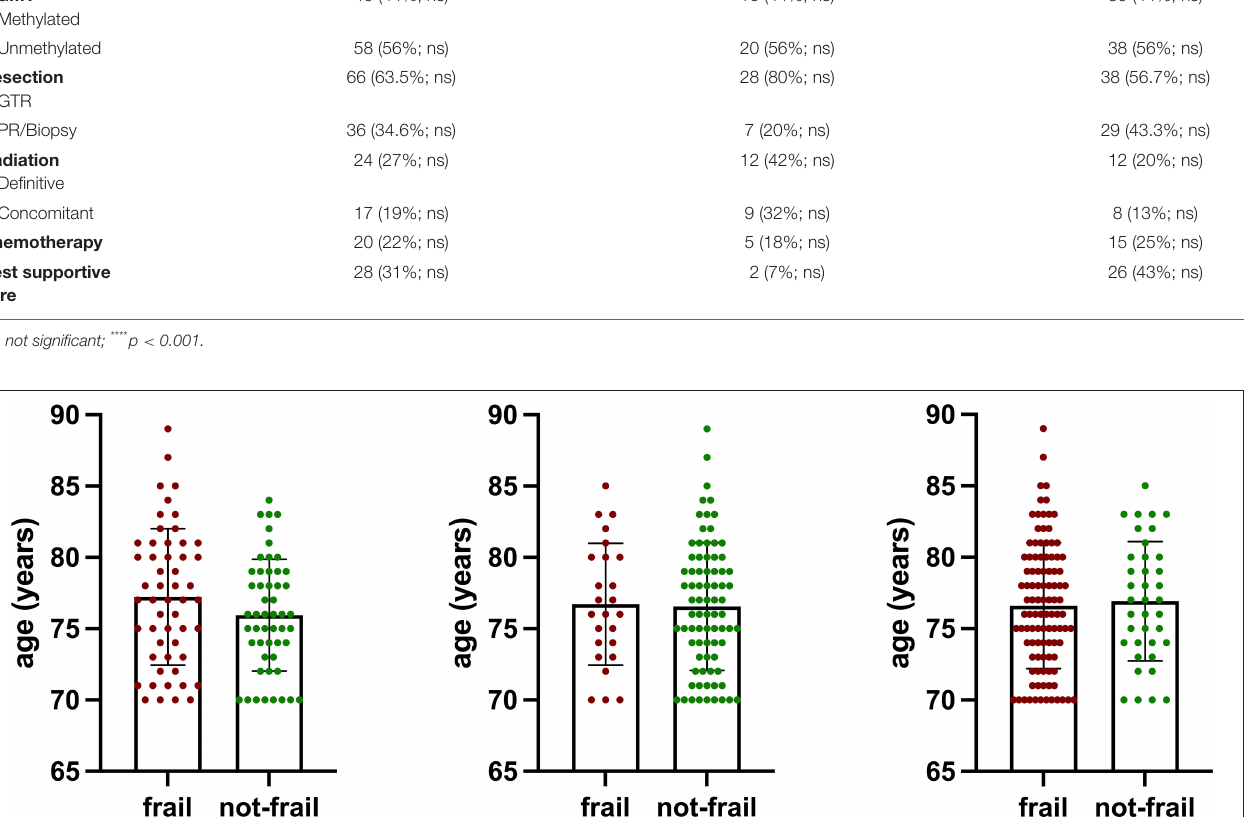
Frail patients ( n =